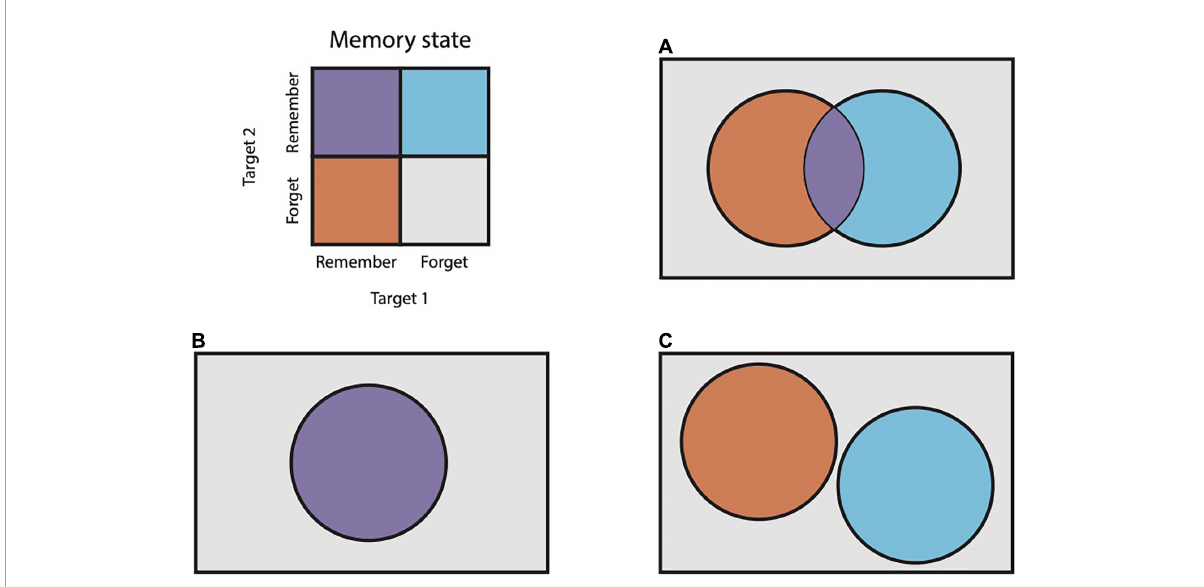
FIGURE1 Venn diagrams of pairs of random variables. (A) Two random variables that are statistically independent. (B) Two random variables with positive correlation. (C) Two random variables with negative correlation. In this case, the variables are mutually exclusive.